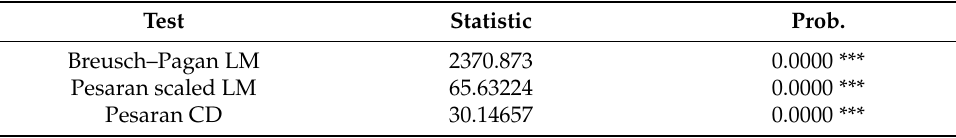
Table 5. Cross-sectional dependence test results.